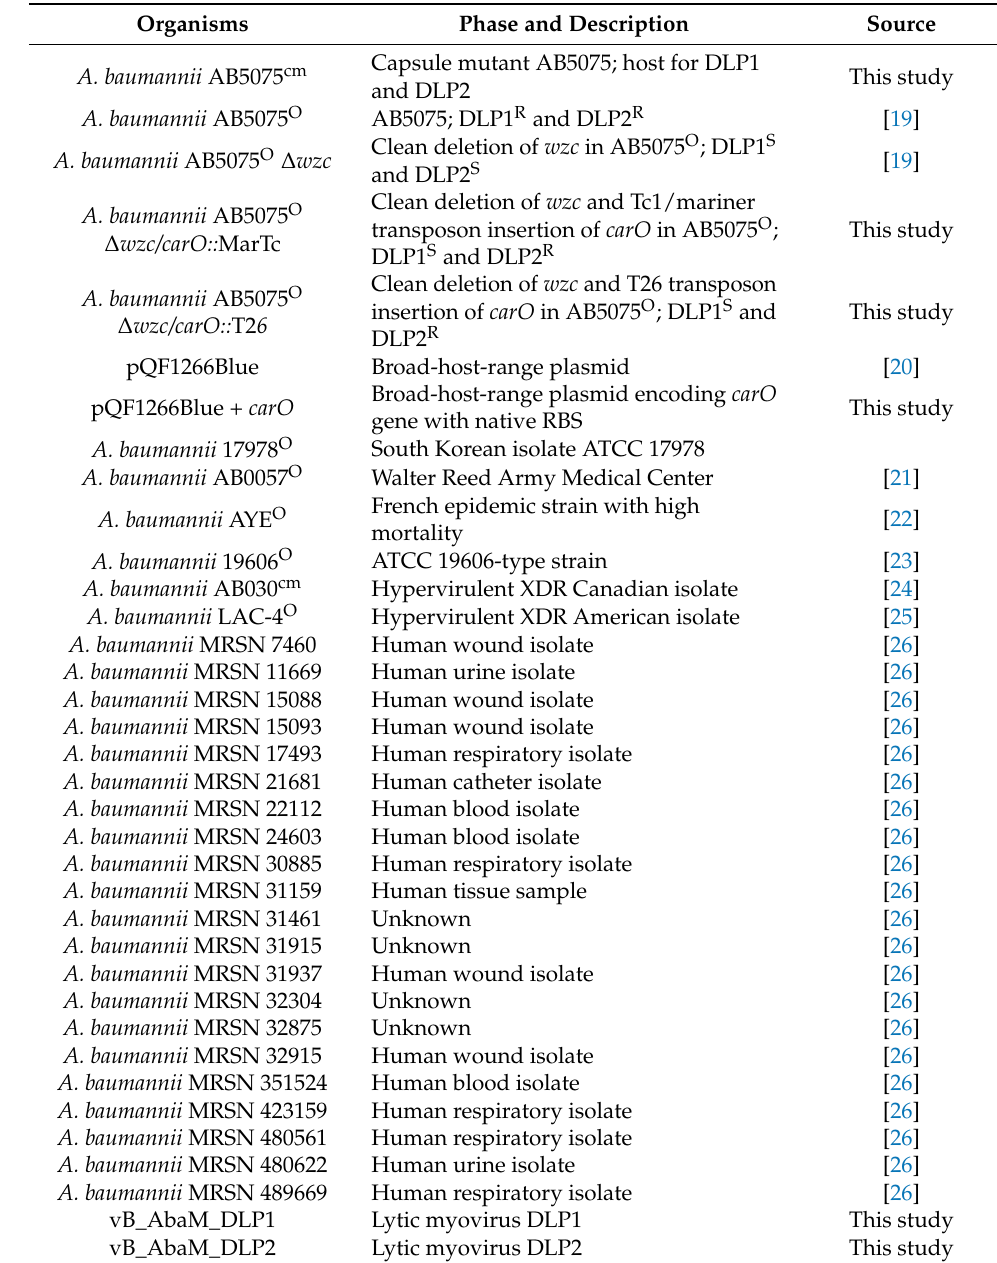
Table 1. List of bacterial strains and phages used in this study. Organisms Phase and